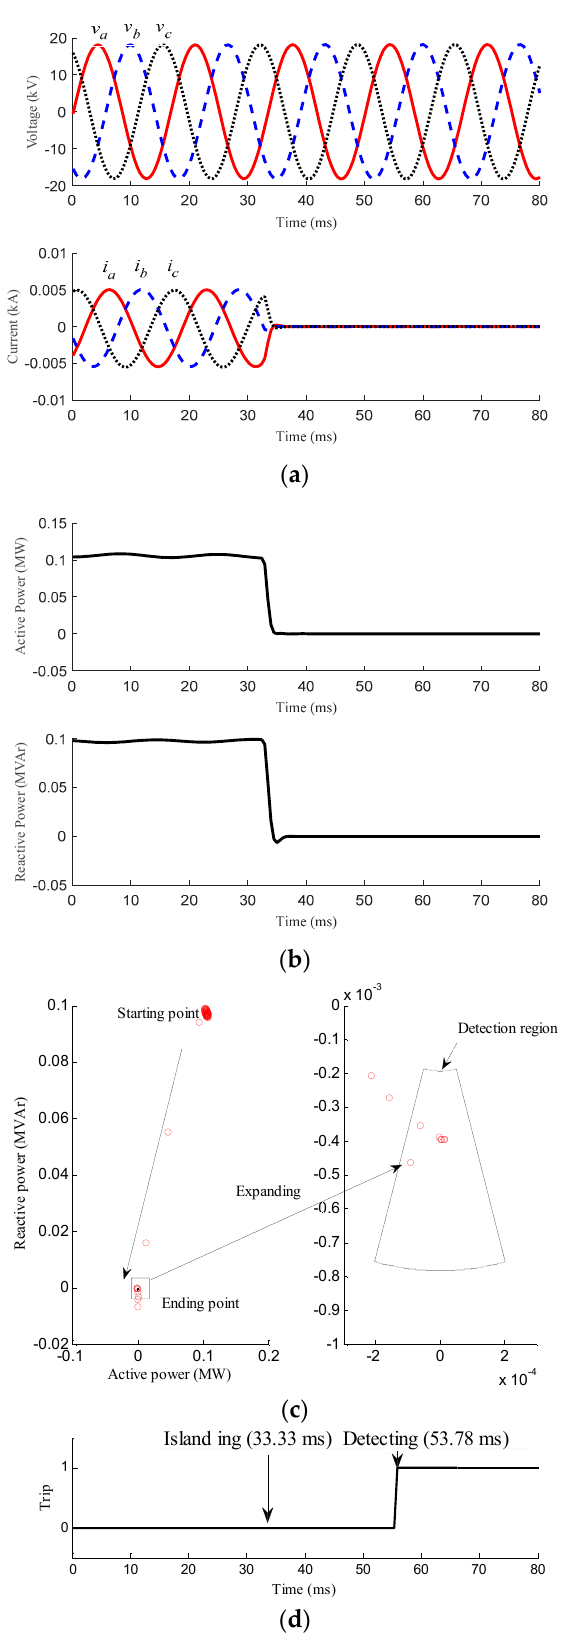
Figure 4. Results for Case 2. ( a ) v a , b , c (upper) and i a , b , c (lower); ( b ) p 3 ph (upper) and q 3 ph (lower); ( c ) Trajectories of the point ( p 3 ph , q 3 ph ); ( d ) Islanding detection signal.